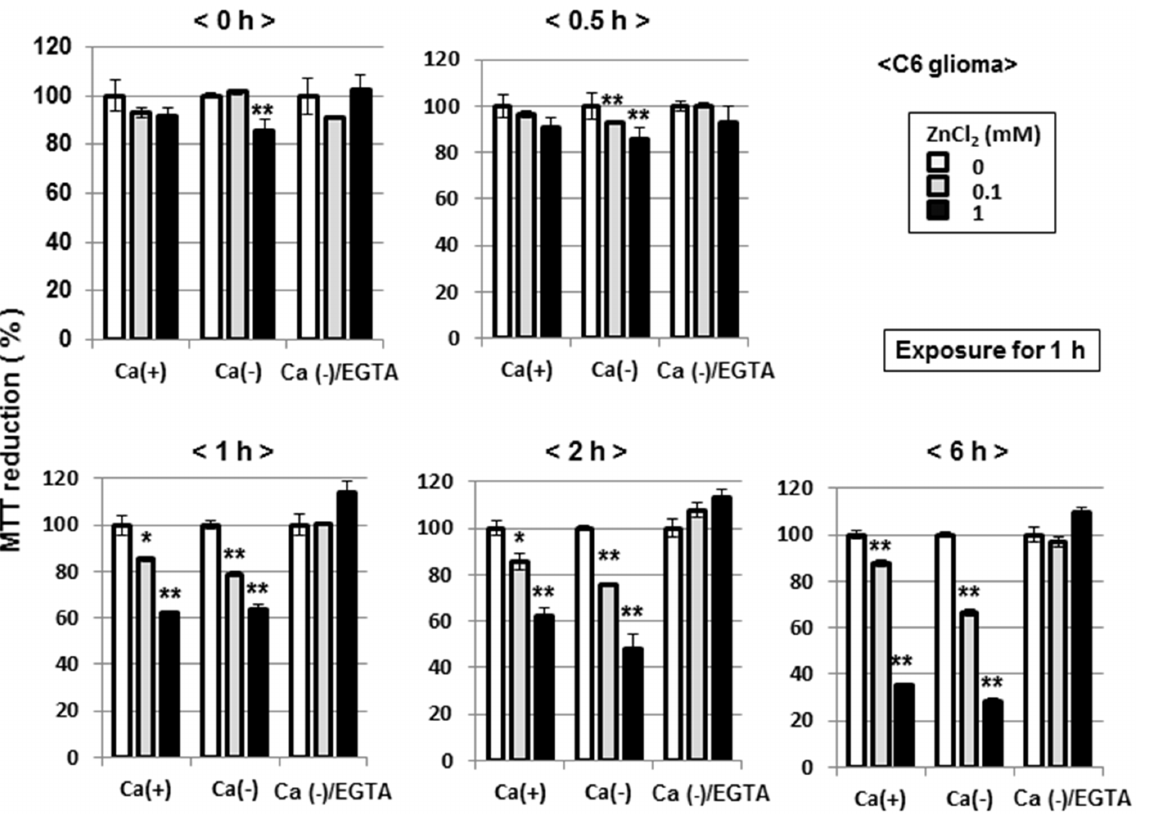
Fig 15. Effects of culture periods on ZnCl 2 -induced inhibition of MTT reducing activity in C6 glioma cells. Cells were exposed to ZnCl 2 at 0.1 or 1 mM in either the presence or absence of CaCl 2 and EGTA for 1 h, followed by culture for an additional periods from 0.5 to 6 h and subsequent determination of MTT reducing activity. Values are the mean ± S.E. of percentages over the maximal activity detected in cells not exposed to any test chemicals in 3 different experiments. * P < 0.05, ** P < 0.01, significantly different from the control value in cells not exposed to ZnCl 2 .